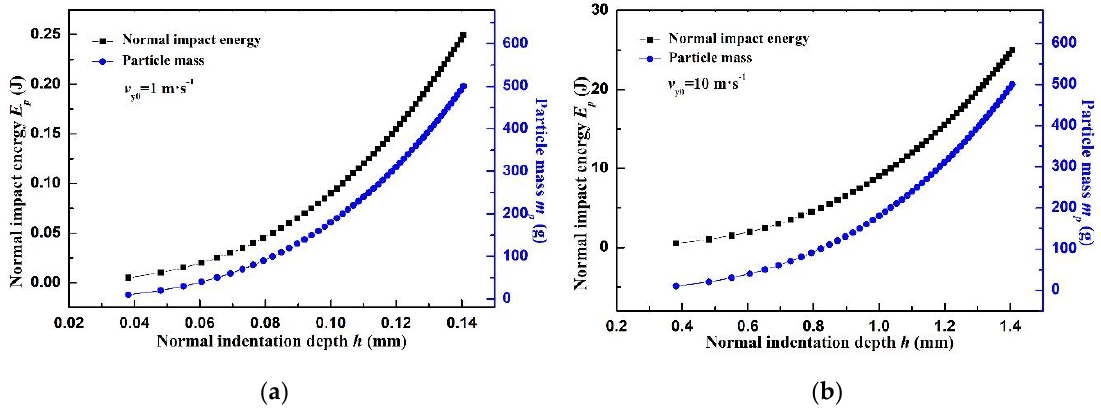
Figure 5. The impact energy and normal indentation depth versus different particle mass (Q235 for target wall): ( a ) normal impact velocity is 1 m/s; ( b ) normal impact velocity is 10 m/s.